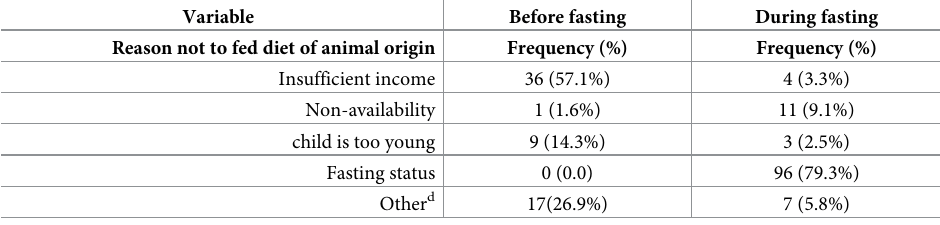
Table 3. Mothers/caregivers’ reasons for not feeding foods of animal origin to their children (before and during the fasting period in Debrebirhan, North Shewa Zone Ethiopia, 2019.